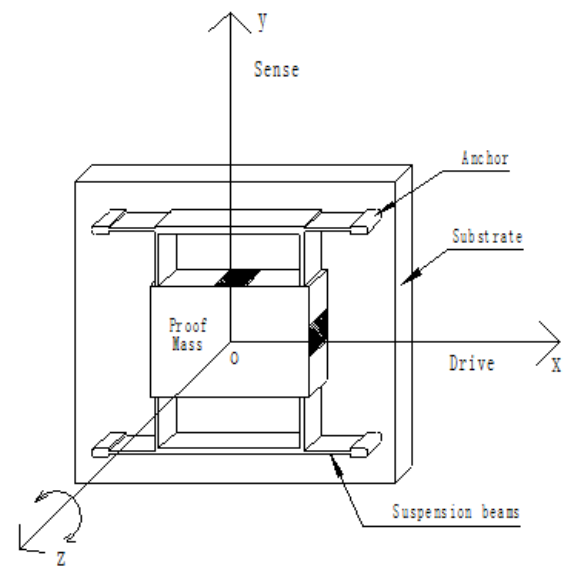
Figure 1. A generic MEMS gyroscope with the driving